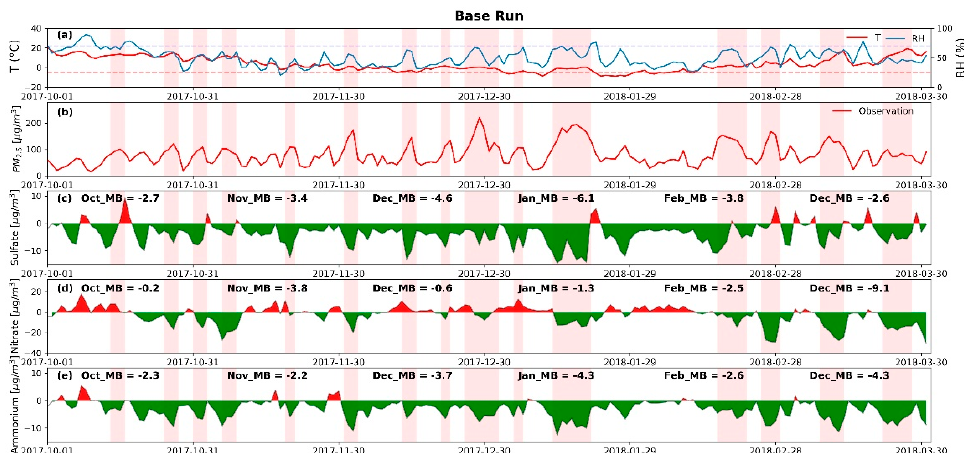
Figure 3. ( a ) Observed T and RH at corresponding sites from 1 October 2017 to 31 March 2018. The blue dotted line represents RH equal to 70%, and the red dotted represents the T equal to − 5° ( b ) Observed PM 2.5 at corresponding sites from 1 October 2017 to 31 March 2018. The red background represents the polluted period. ( c – e ) Model bias (the mean value of 28 sites) simulated under the base scheme of sulfate, nitrate, and ammonium from 1 October 2017 to 31 March 2018. The red area indicates a positive bias, and the green area indicates a negative bias.